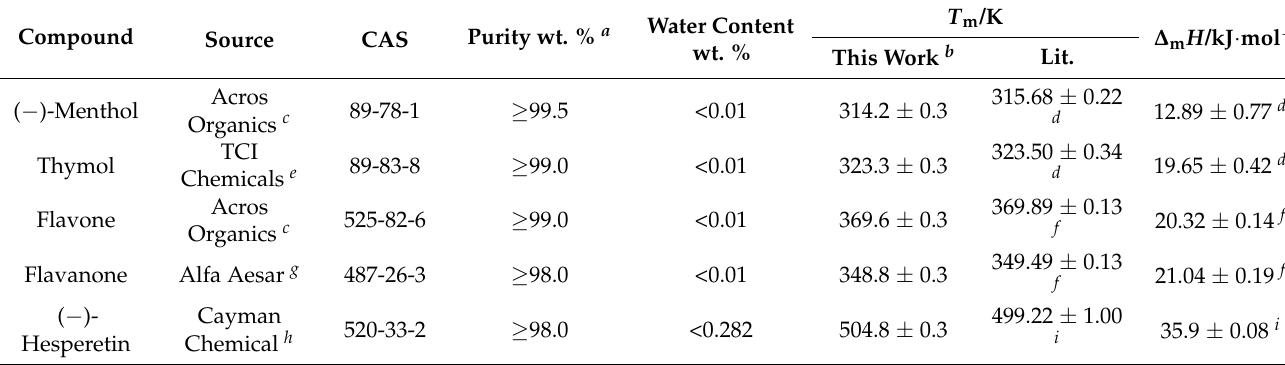
Table 1. Compound description and their melting